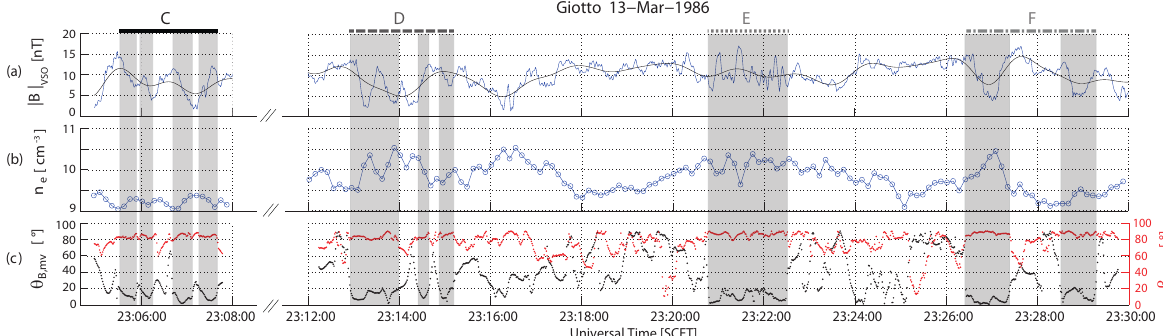
Figure 3. Time series of (a) total magnetic field, (b) electron density and (c) angles ( θ and β ) between the maximum and minimum variance directions and the background magnetic field, based on Giotto data.